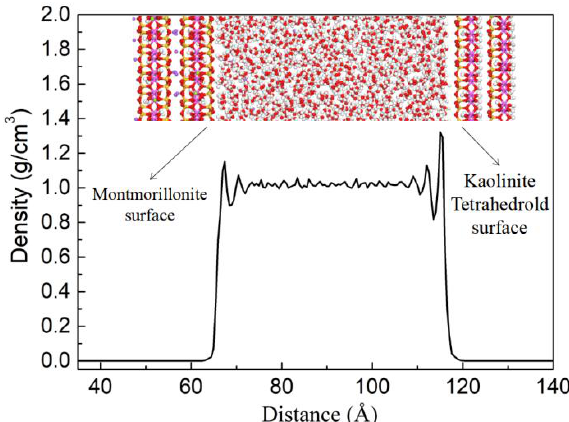
Figure 17. Density distribution of water on the surface of montmorillonite and the tetrahedron surface of kaolinite.